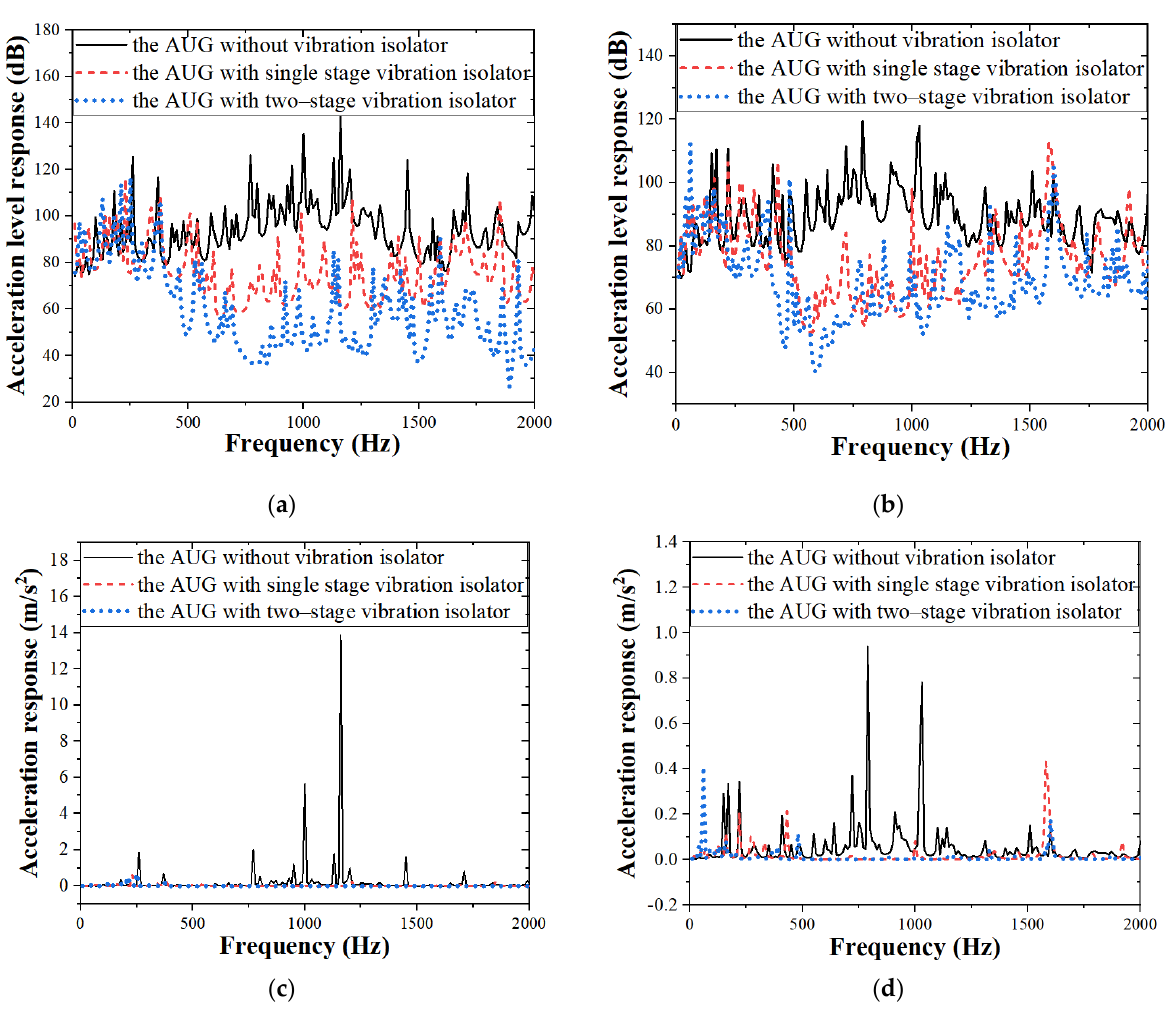
Figure 15. The acceleration level and acceleration requency responses of the AUG with single- and two-stage vibration isolation: ( a ) in air; ( b ) in water; ( c ) in air; ( d ) in water.